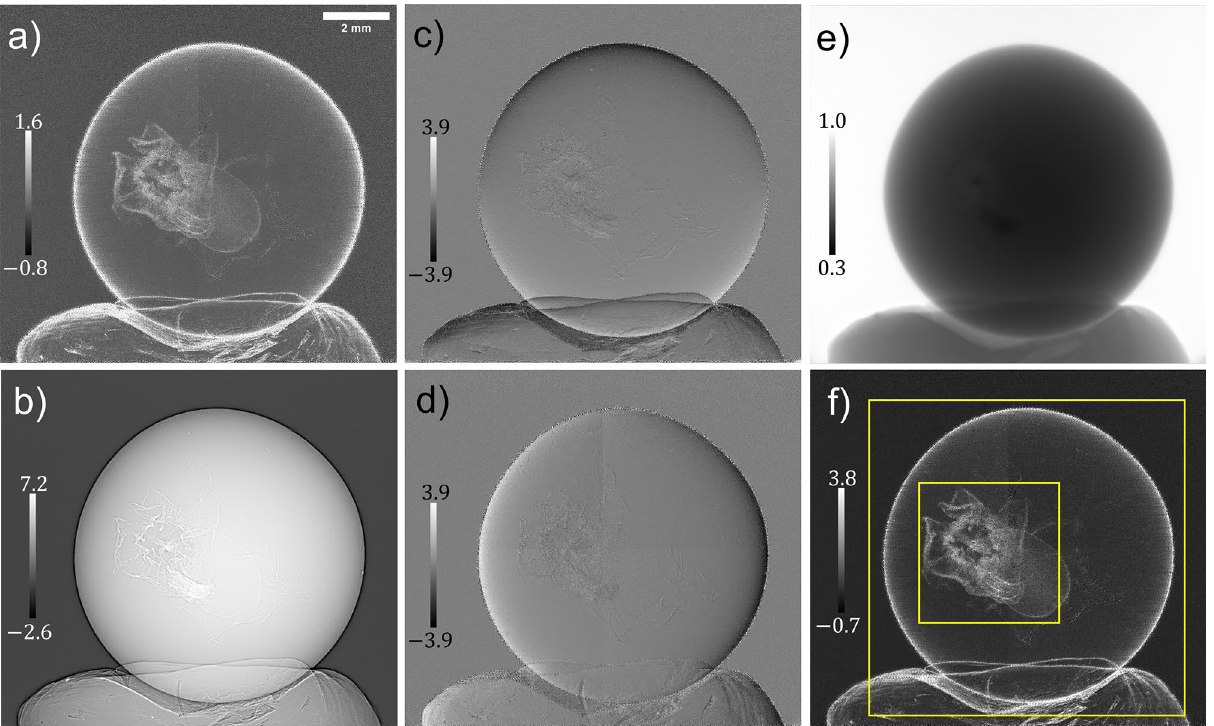
Figure 5. Solutions of the system of linear equations, equation (6), and the red currant’s reconstructed multimodal signals; ( a ) is the effective diffusion coefficient, D eff, Phase ( r ; �) , ( b ) is 1 , ( c , d ) are the two spatial derivatives of the effective diffusion coefficient, 2 φ ob ( r ) (cid:28)) D eff,Phase ( r k Recon ∇ − ; ⊥ (cid:30)) and D x eff, Phase ( r ; �) , respectively, ( e ) is the reconstructed attenuation term, I ob ( r ) , and ( f ) is the red D y eff,Phase ( r (cid:31) (cid:30) ; currant’s optimally filtered true effective diffusion coefficient, D True eff, Atten ( r ; �) . The greyscale bars in subfigures ( a , f ) are × 10 − 5 µ m, ( b ) is × 10 − 7 µ m − 1 , and ( c , d ) are × 10 − 6